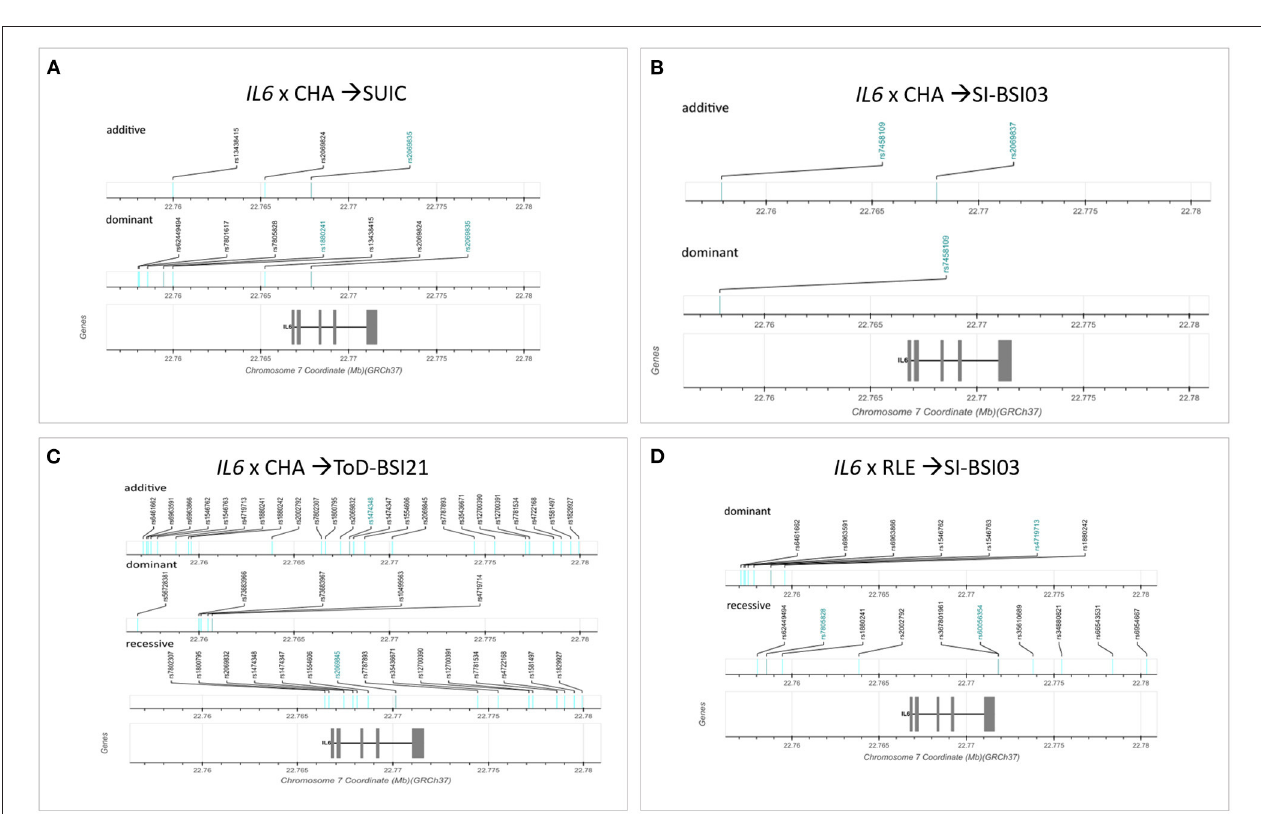
FIGURE 6 | Genomic location of significant clumps of SNPs in the IL6 gene influencing suicidal phenotypes in interaction with different types of stress. Logistic regression models on the interaction between IL6 and childhood adversities on lifetime suicide attempts yielded three significant clumps (one for additive and two for dominant models) (A) . Linear regression models on the interaction between IL6 and childhood adversities on current suicidal ideation (SI-BSI03) yielded three significant clumps (two for additive and one for dominant models) all consisting of one SNP each (B) . Linear regression models on the interaction between IL6 and childhood adversities on current thoughts of death (ToD-BSI21) yielded three significant clumps (C) . Linear regression models on the interaction between IL6 and recent negative life events (RLE) on current suicidal ideation (SI-BSI03) yielded three significant clumps (D) . Top SNPs are marked with blue for each clump. The exons are marked with grey rectangles on the gene. Figures are based on diagrams generated by LDlink, LDmatrix Tool (https://ldlink.nci.nih.gov/?tab=ldmatrix).